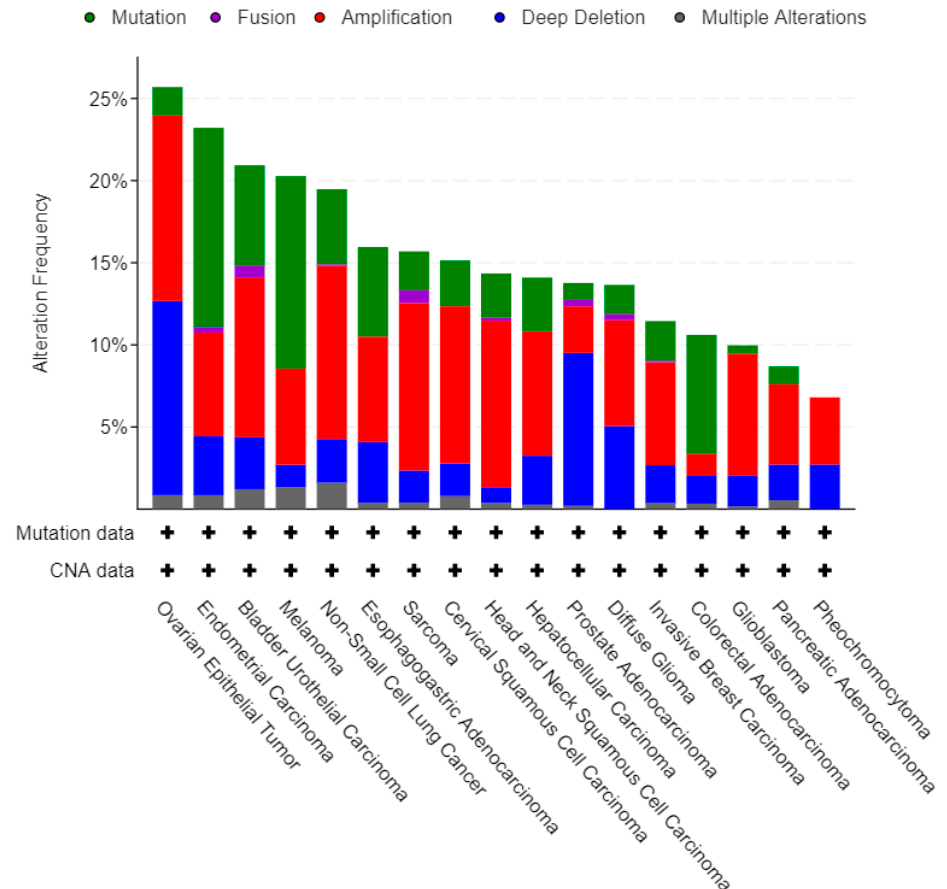
Figure 3. Global analysis of the cumulative alteration frequency of the queried genes per cancer type revealed that ovarian, endometrial, and bladder urothelial carcinomas are the three types of cancer with the higher frequency of mutation in the 5FU conversion system; only cases with > 5% changes, occurring in a minimum of 100 total cases are represented; CNA, copy number alteration. Data retrieved from 32 studies including 10953 patients, TCGA PanCancer Atlas.